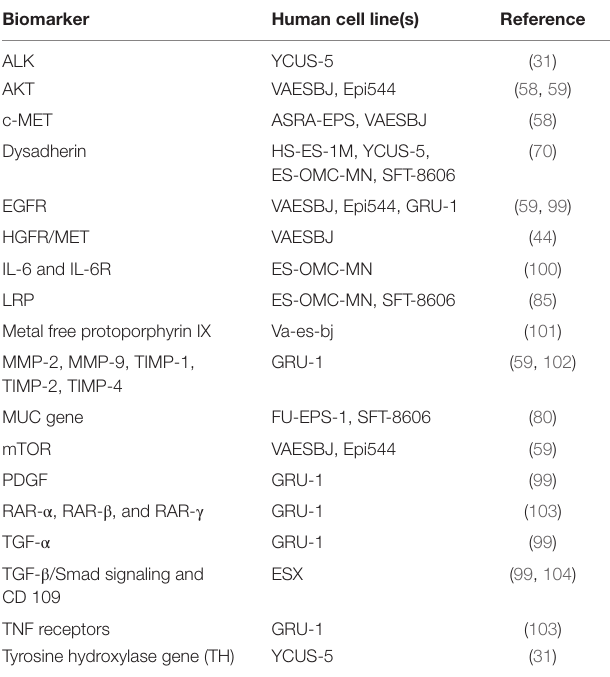
TABLe 2 | epithelioid sarcoma potential targets and corresponding experimental model systems.